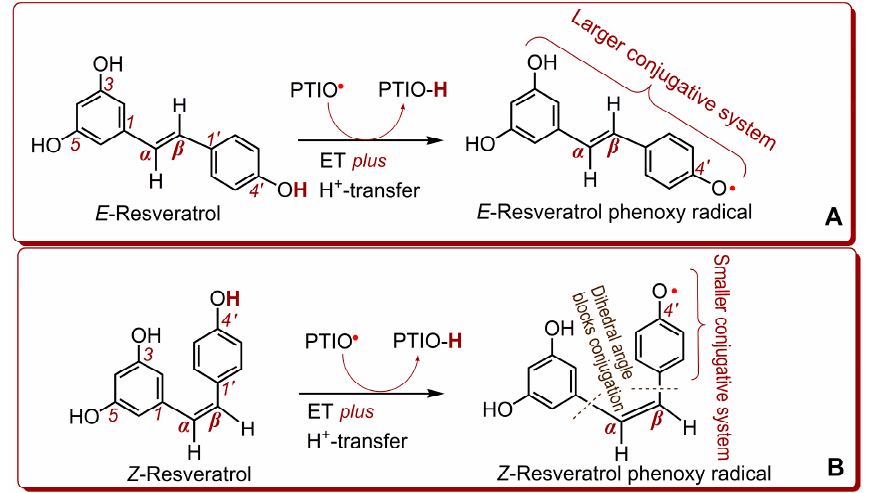
Figure 2. The proposed reactions of E -resveratrol ( A ) and Z -resveratrol ( B ) with PTIO radical via ET plus H + -transfer pathways.